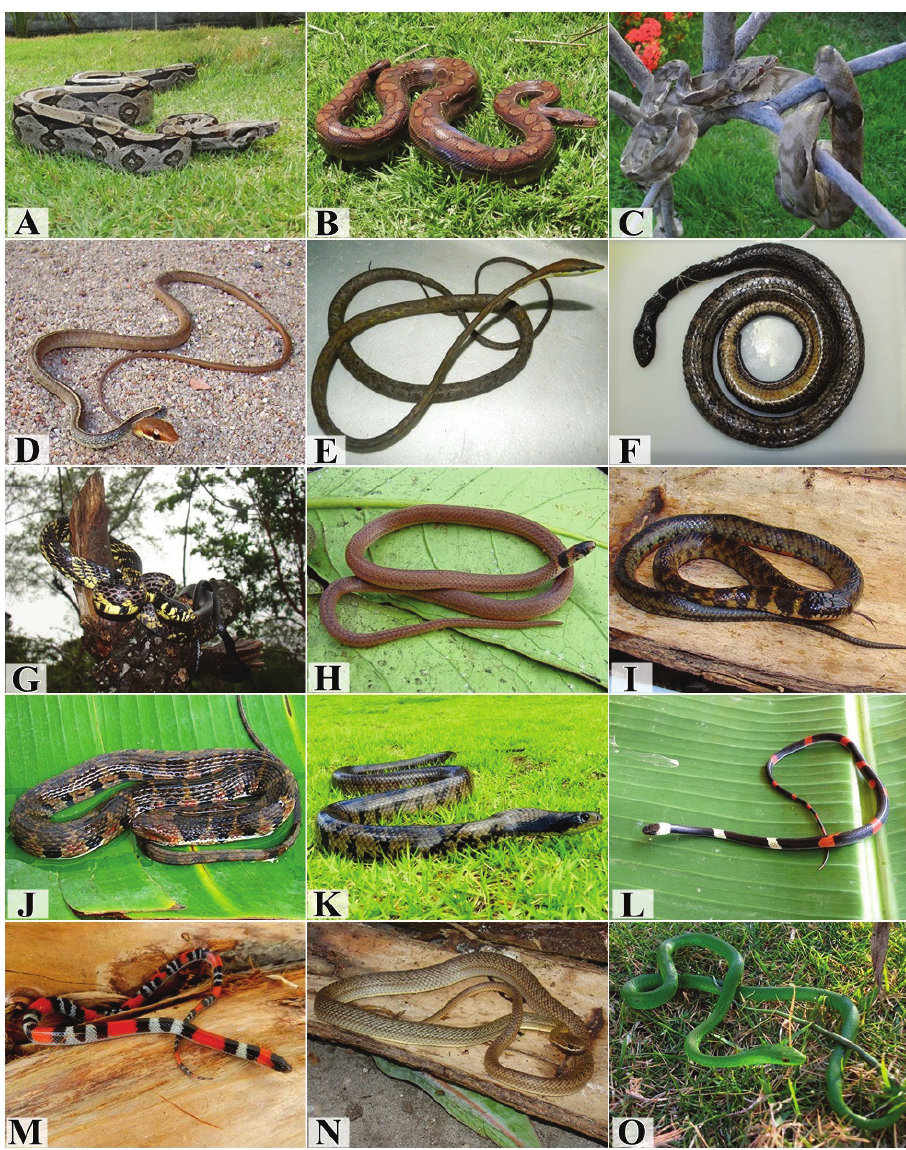
Figure 4. Species from the Atlantic Forest in south coast of Paraíba. A Boa constrictor B Epicrates assisi C Corallus hortulanus D Chironius flavolineatus E Oxybelis aeneus F Mastigodryas bifossatus G Spilotes pullatus H Tantilla melanocephala I Erythrolamprus taeniogaster J Helicops angulatus K Hydrodynastes gigas L Oxyrhopus petolarius M Oxyrhopus trigeminus N Philodryas nattereri O Philodryas olfersii . Photograph credits: Ivan L. Sampaio ( A, B, C, E, K, L, M, N, O ), Frederico G. França ( D, H, I, J ), Mayara Morais ( F ), Willianilson Pessoa ( G